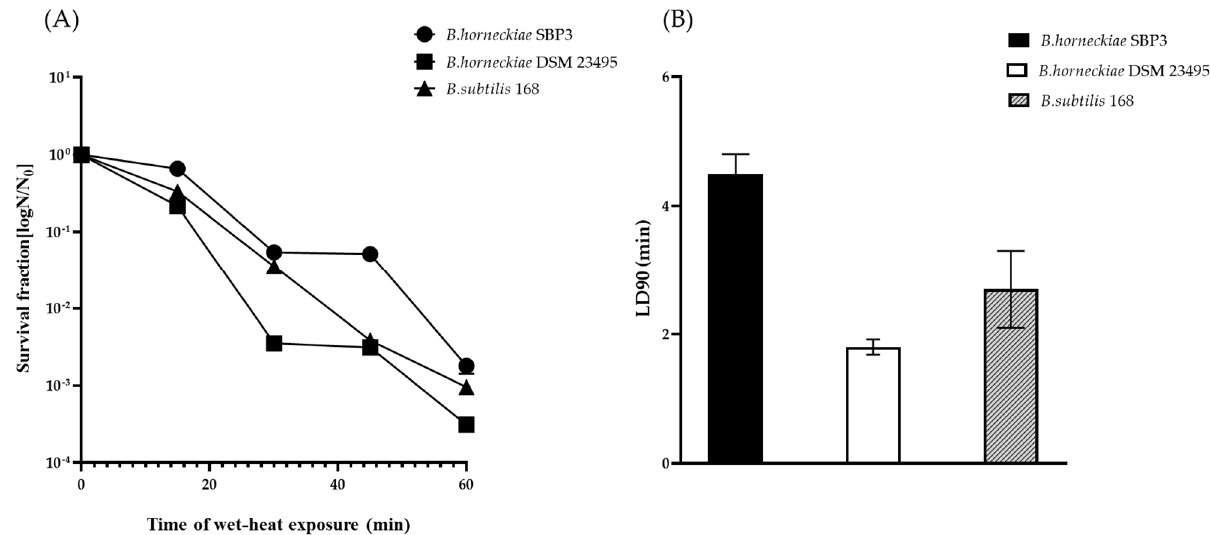
Figure 4. Resistance to wet heat (98 ◦ C) of spores from B. horneckiae SBP3, B. horneckiae DSM 23495 and B. subtilis : ( A ) survival curves of spores and ( B ) bar graph displaying the LD 90 values (i.e., time to reduce spore survival to 10% of the initial spore culture).